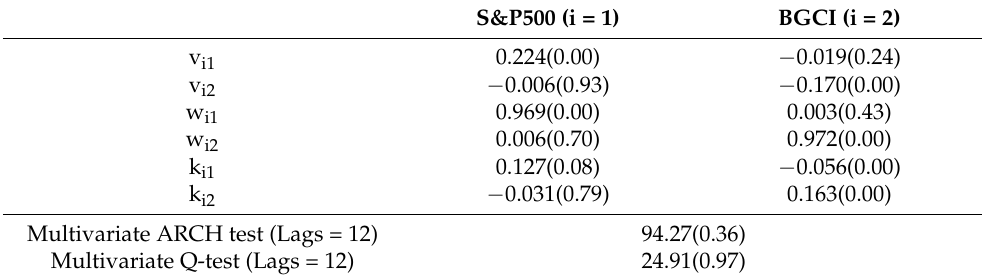
Table 3. Asymmetric MGARCH.